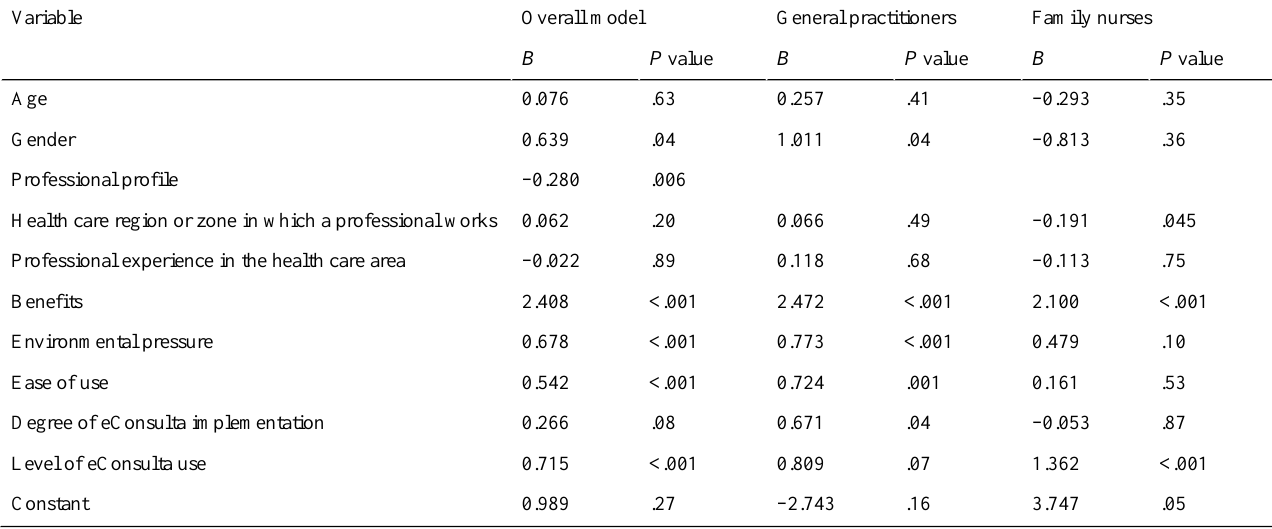
Table 6. Significant variables for the three calculated models.